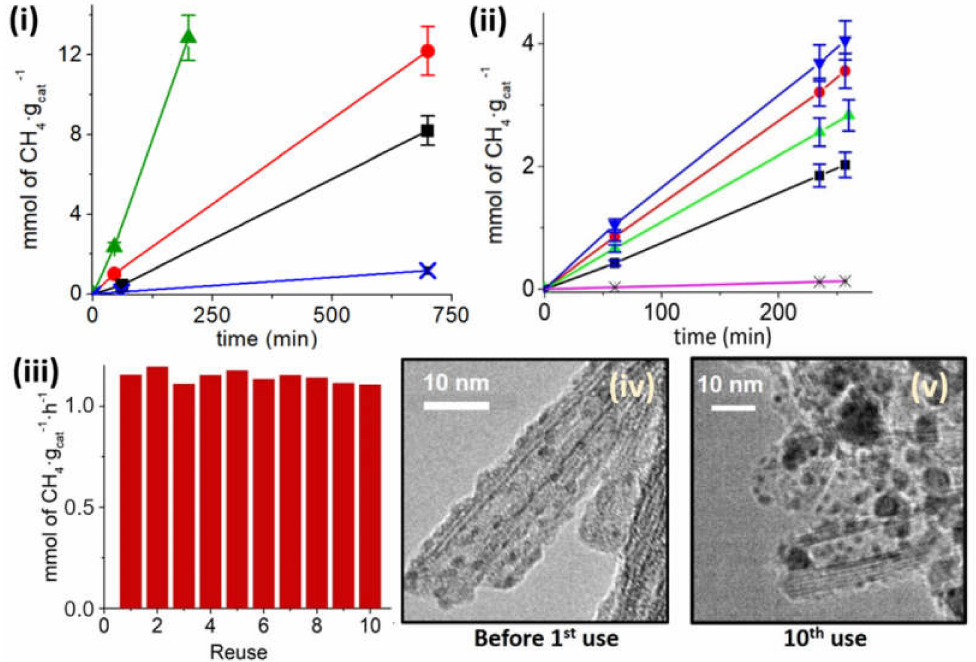
Figure 6. ( i ) Photothermal catalytic reduction of CO 2 with Ru / TiNT-3.5 at 180 ◦ C in the dark ( × ) and under irradiation with simulated sunlight of 100 mW / cm 2 ( (cid:4) ), 150 mW / cm 2 ( • ). or 230 mW / cm 2 ( (cid:78) ). ( ii ) Photothermal catalytic reduction of CO 2 at 180 ◦ C utilizing Ru / TiNT-11; the production was normalized according to light intensity used in each light region. Only heat ( (cid:4) ), only simulated sunlight ( × ), visible ( (cid:78) ), near-infrared ( (cid:72) ), and UV ( • ). ( iii ) Reusability experiment for Ru / TiNT-11, performed at 210 ◦ C upon irradiation with simulated sunlight of 150 mW / cm 2 . HR-TEM images of Ru / TiNT-11 sample: ( iv ) fresh prepared sample and ( v ) same sample after 10